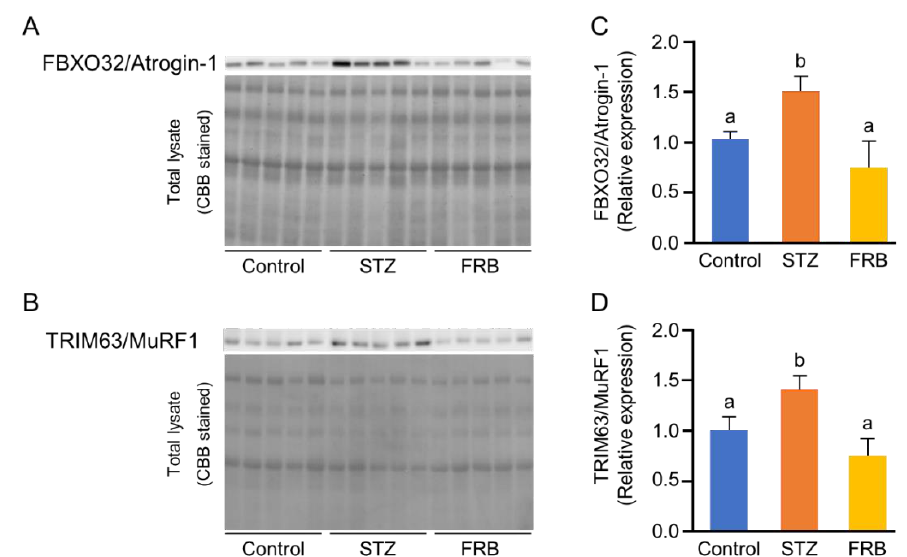
Figure 6 . FRB decreased the expression of muscle-specific ubiquitin ligases. Representative blots of ( A ) FBXO32/Atrogin-1 and ( B ) TRIM63/MuRF1. The quantification of ( C ) FBXO32/Atrogin-1 and ( D ) TRIM63/MuRF1. Data are shown as the means + SEM. Significance ( p < 0.05, n = 5) among groups is denoted by different letters (a, b).